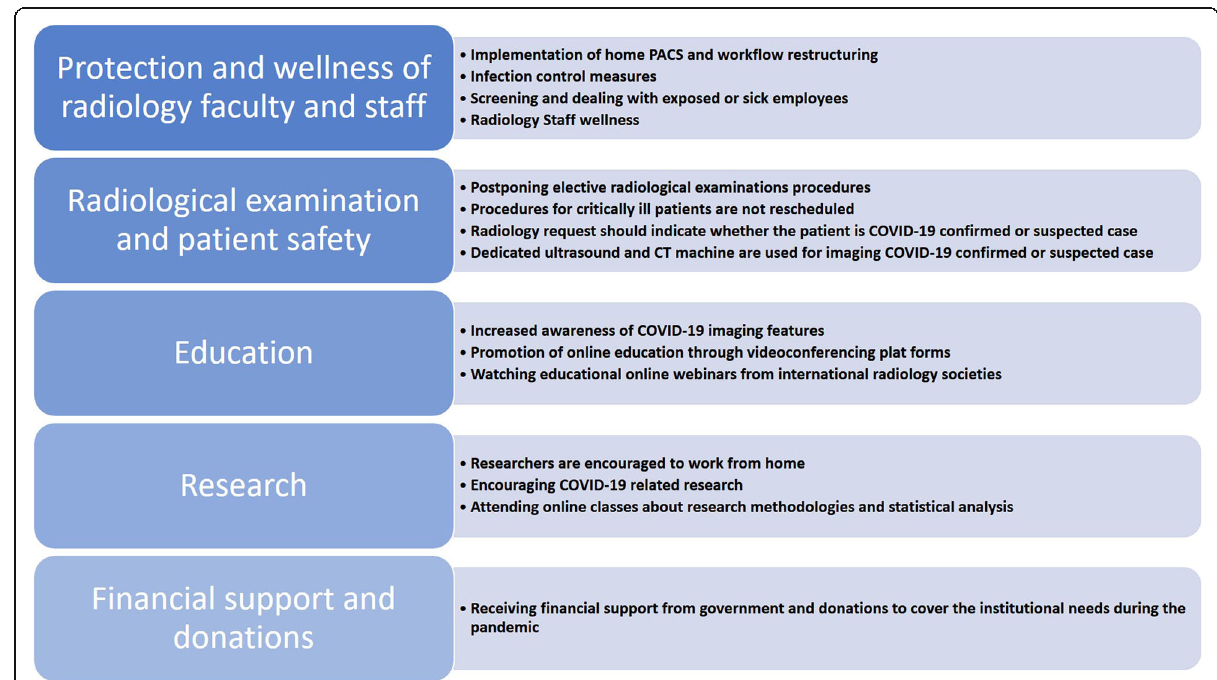
Fig. 1 Radiology department preparedness strategy when facing COVID-19